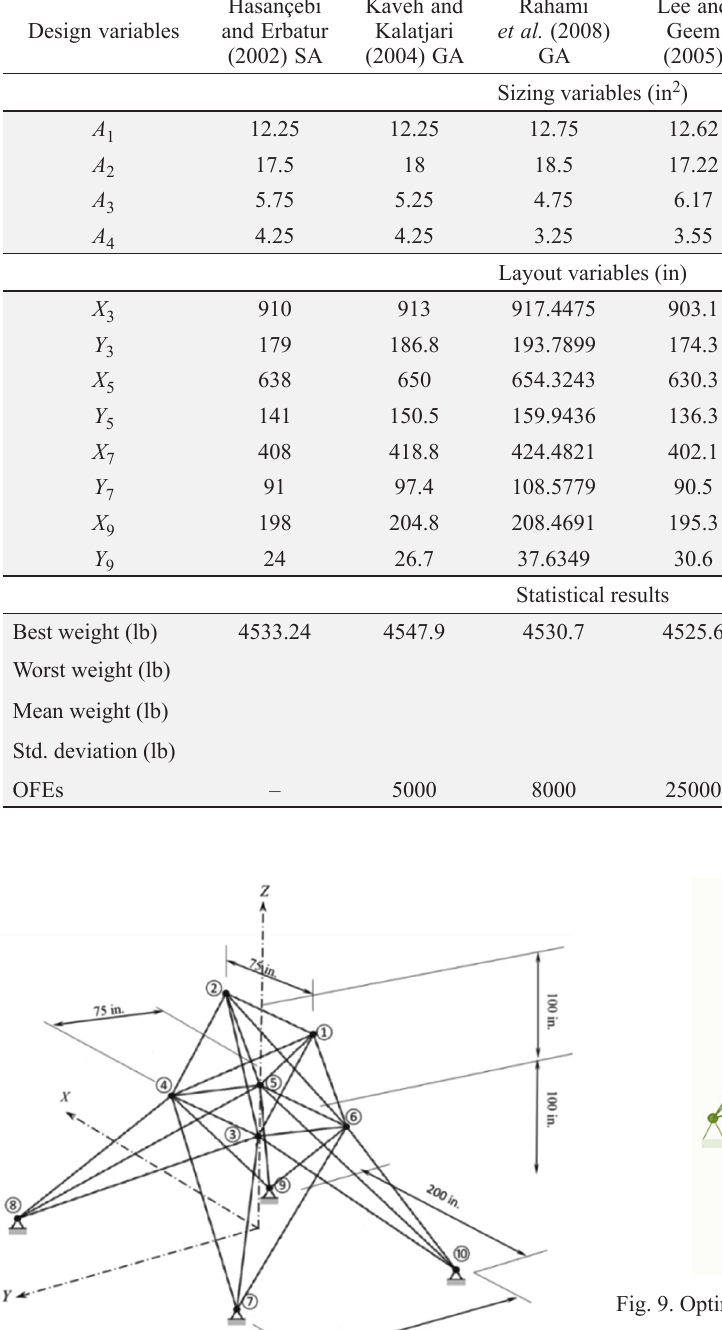
Table 4. Comparison of the iPSO optimization results with the literature for the planar 18-bar truss problem Design variables